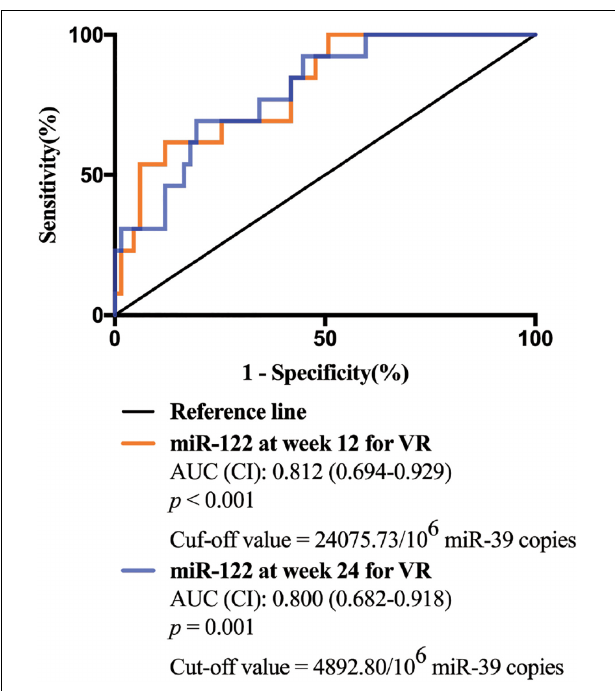
FIGURE 3 | The receiver operating characteristic (ROC) curve analyses of the sensitivity and specificity of miR-122 levels in serum for the prediction of virological response at week 96. Both miR-122 levels at week 12 and week 24 were analyzed.